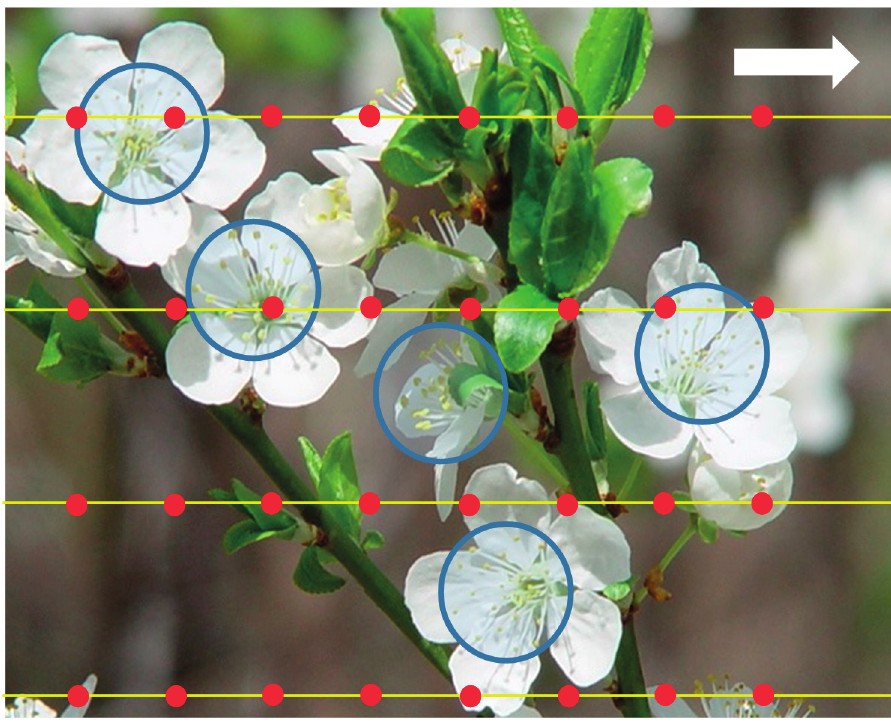
Figure 2. An illustration of the targeting problem, based on spray pollination of apple blossoms. The target areas are shown as blue circles, the actuator paths are shown as yellow lines, and the positions hit by the spray are shown as red dots.